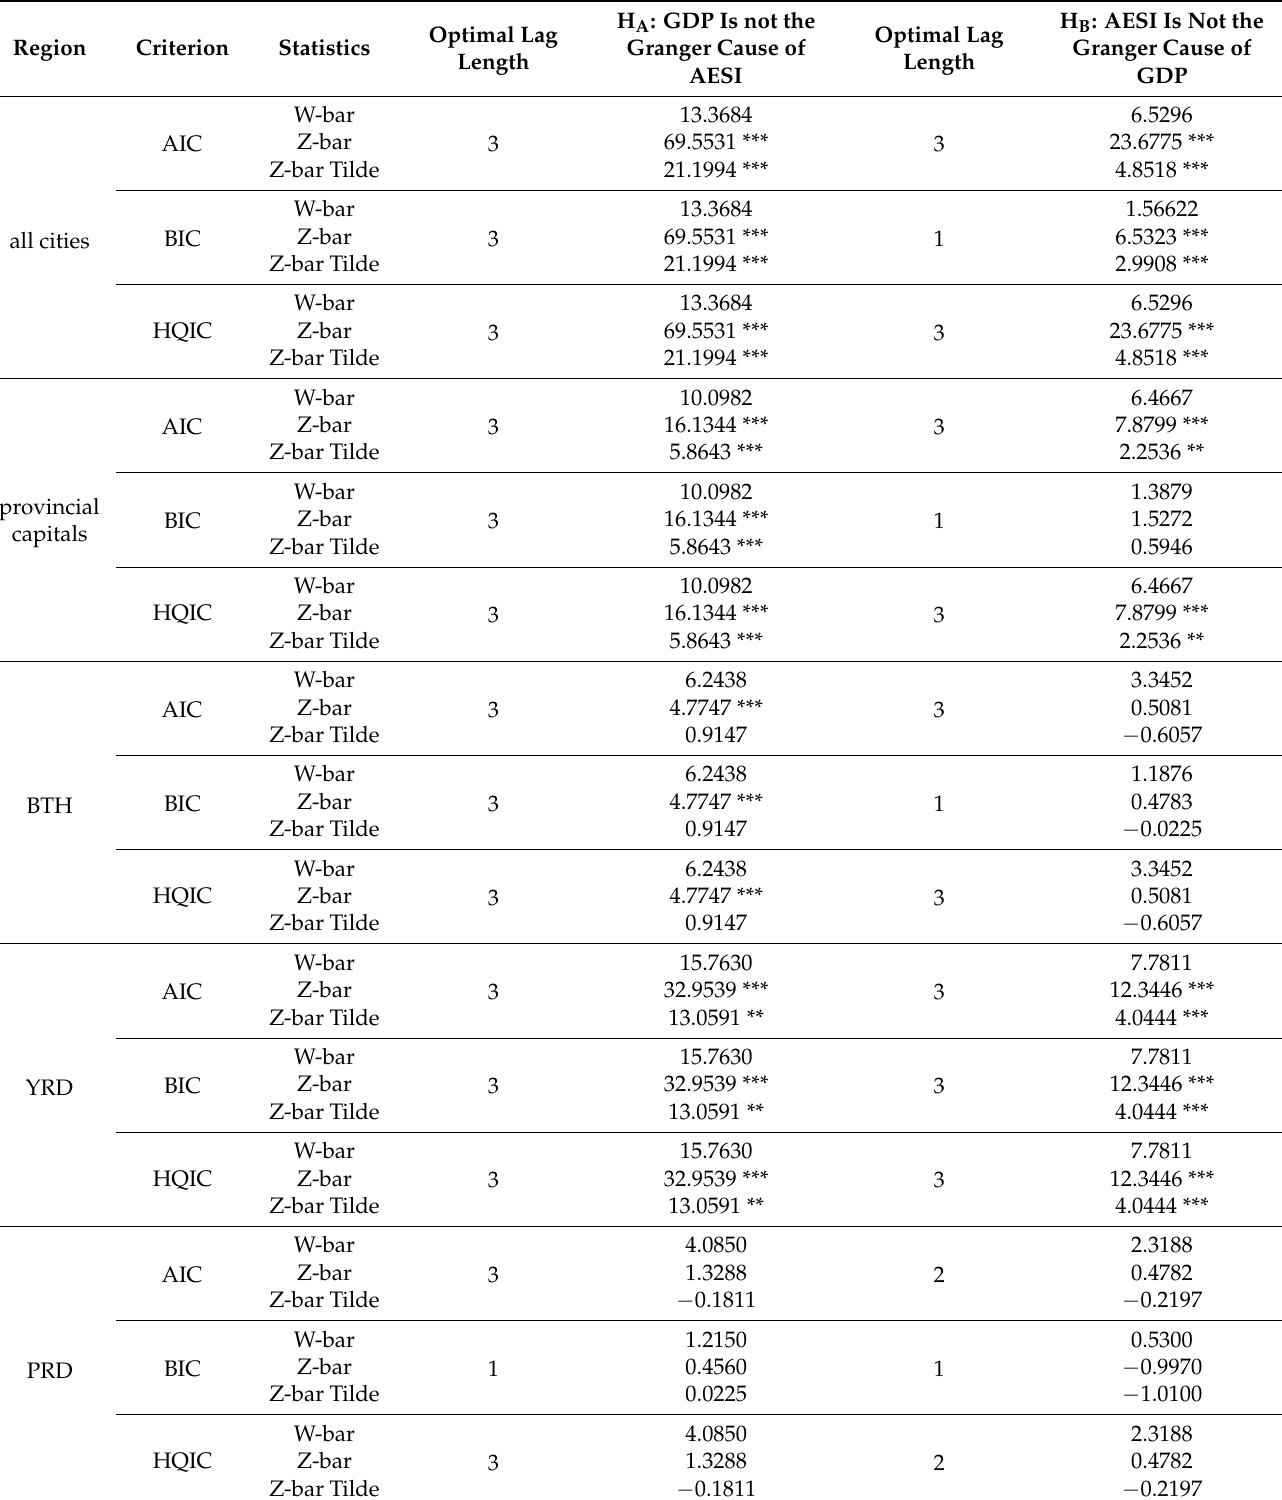
Table 1. The results of panel Granger causality test for all cities, provincial capitals, and three urban